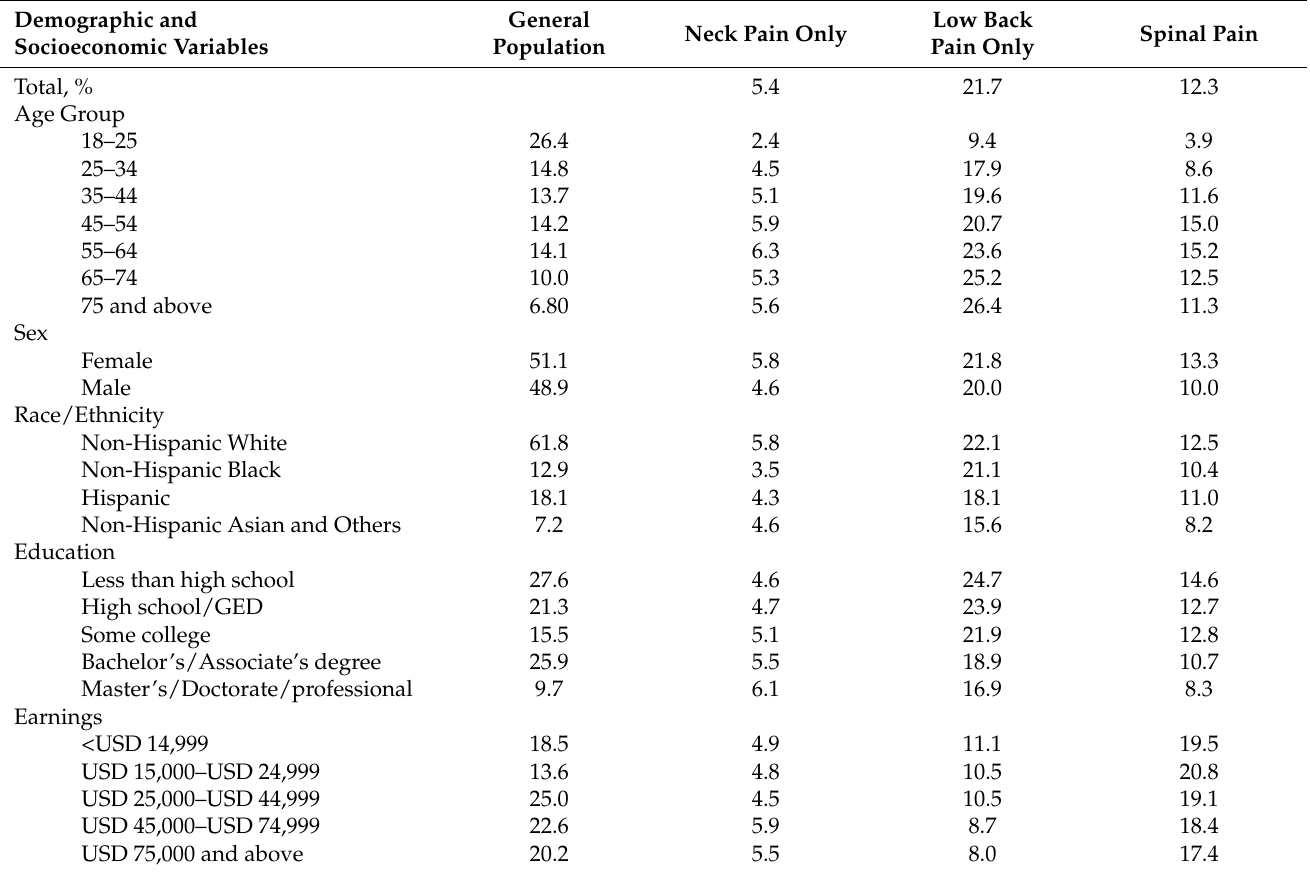
Table 1. Prevalence of low back pain only, neck pain only and spinal pain by demographic and socioeconomic variables in the US adult population,